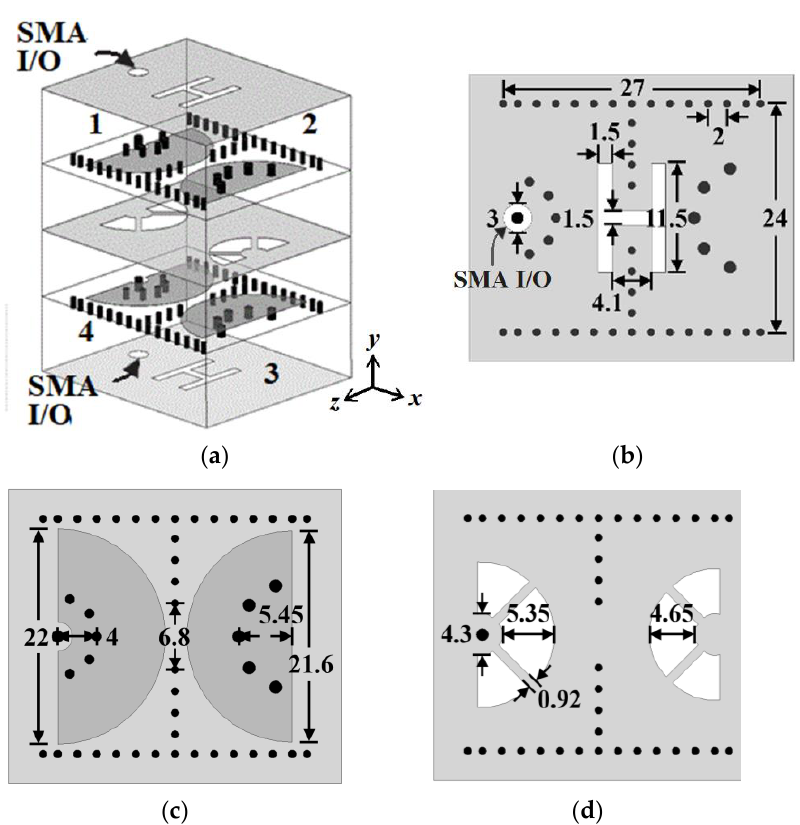
Figure 8. The proposed HMSICR BPF structure: ( a ) the 3-D view; layouts of the ( b ) bottom; and ( c ) middle, and ( d ) top metal layers.